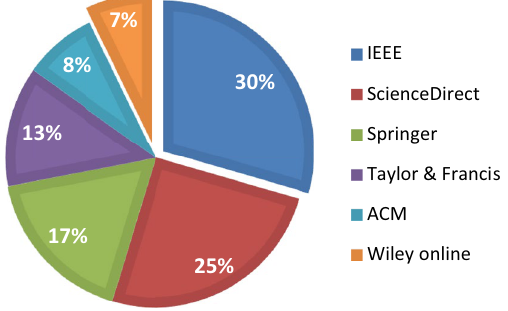
Figure 7. Percentage contribution of each library.